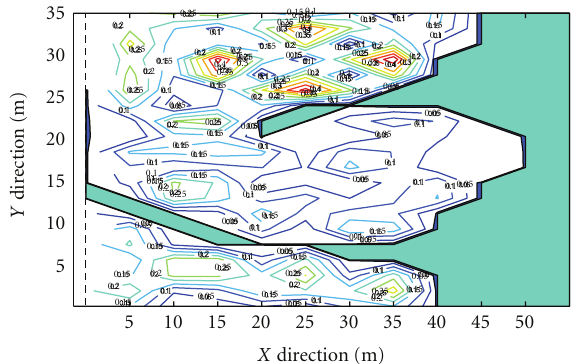
Figure 17: Stable wave heights contour distribution into the